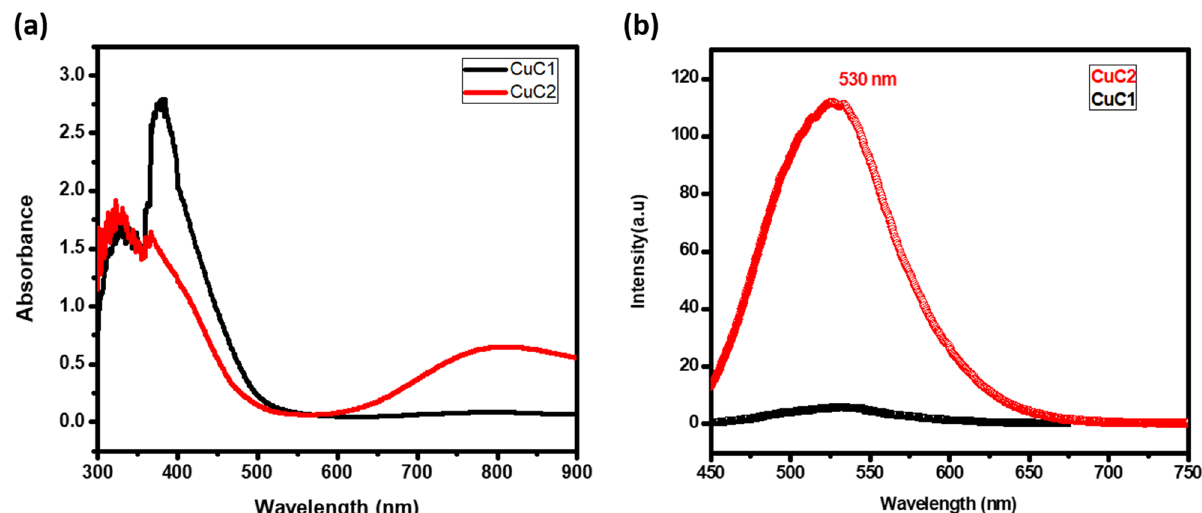
Figure 3. ( a ) UV–Visible spectra and ( b ) Photoluminescent emission spectra of